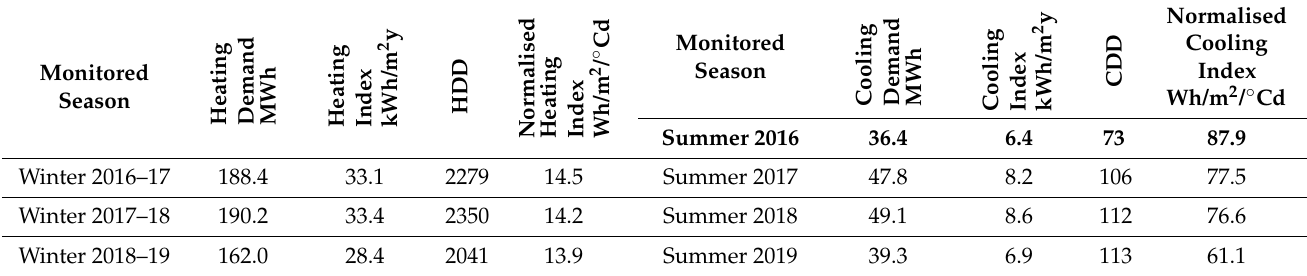
Table 2. Space heating and cooling demands and related indicators (elaborations based on [22]).